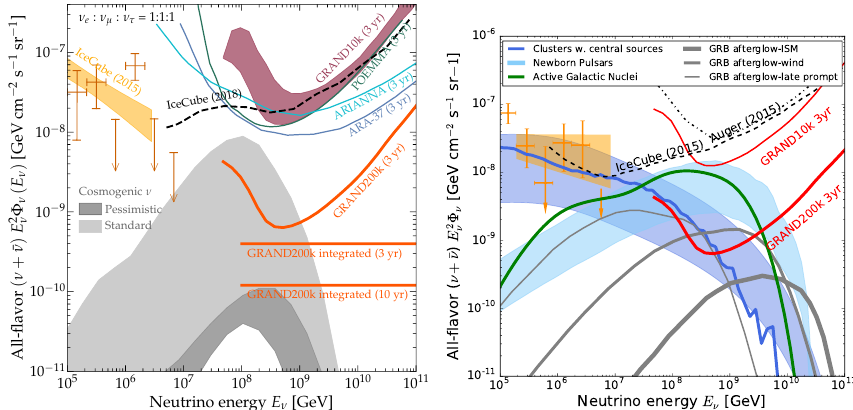
Figure 1: Left: Cosmogenic neutrino flux expectations [ 5 ] and (expected) sensitivi- ties of current and future experiments [ 6–10 ] . Right: expected neutrino fluxes from sources using different source models [ 11–15 ]